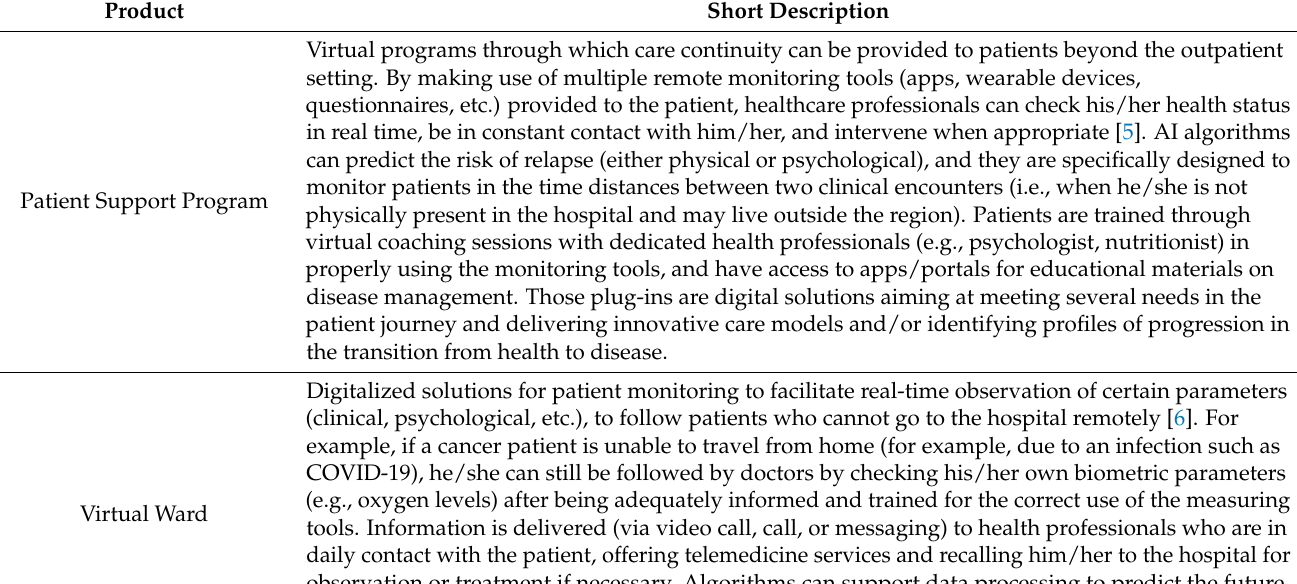
Table 1. Example of digital medicine